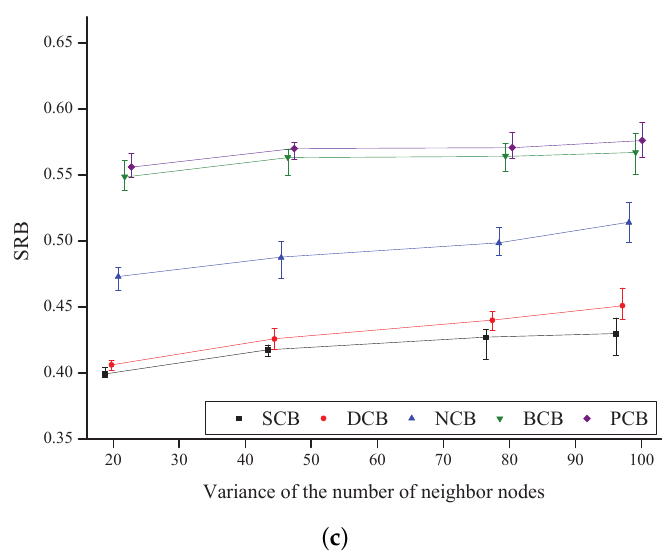
Figure 12. Saved rebroadcast ( SRB ) as a function of the variance of the number of neighbor nodes.